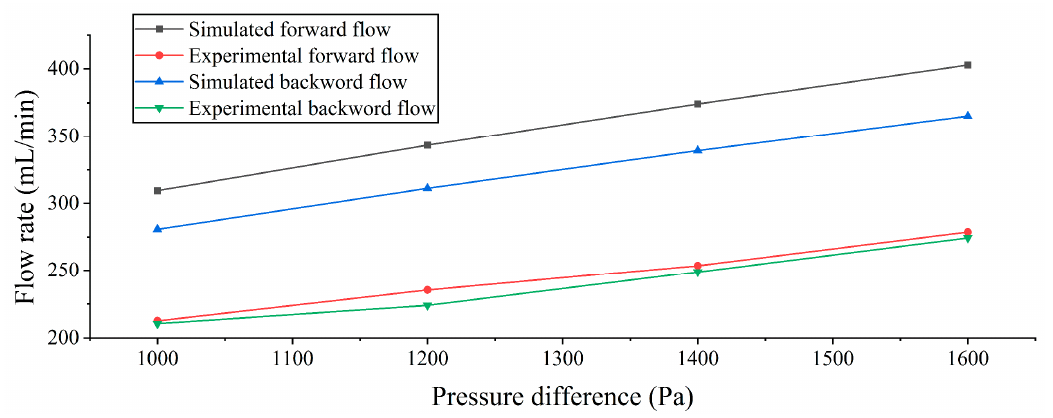
Figure 10. Flow resistance experiment and simulation.